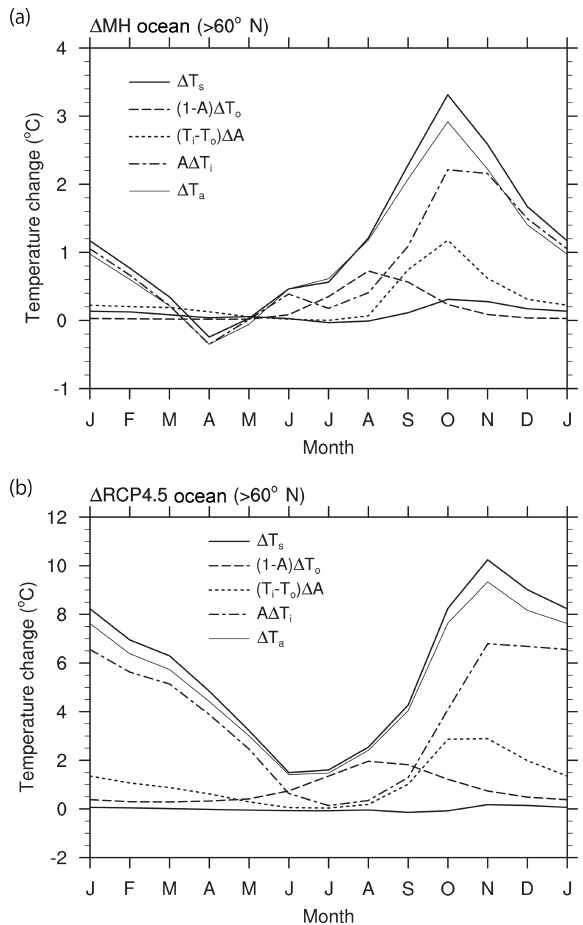
Figure 9. Contribution of the individual components to the surface temperature change ( ◦ C) over the ocean (north of 60 ◦ N): (a) (cid:49) MH and (b) (cid:49) RCP4.5. The surface temperature change is decomposed into the components of the SST change ((1 − A ) (cid:49)T o ), sea ice con- centration change (( T i − T o ) (cid:49)A ), and sea ice surface temperature change ( A(cid:49)T i ). Simulated surface temperature ( (cid:49)T s ) and surface air temperature changes ( (cid:49)T a ) are also plotted for reference. Only five models (bcc-csm-1, CCSM4, CNRM-CM5, IPSL-CM5A-LR, and MRI-CGCM3) are